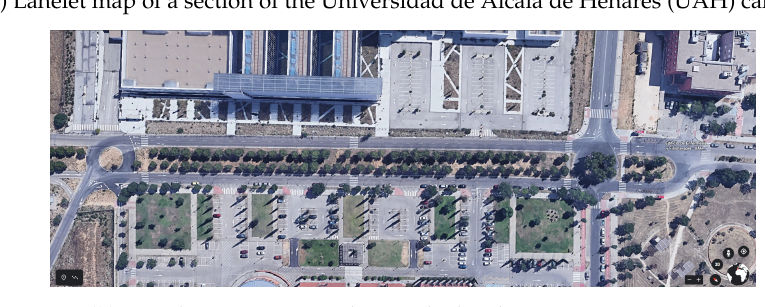
Figure 12. Overtaking